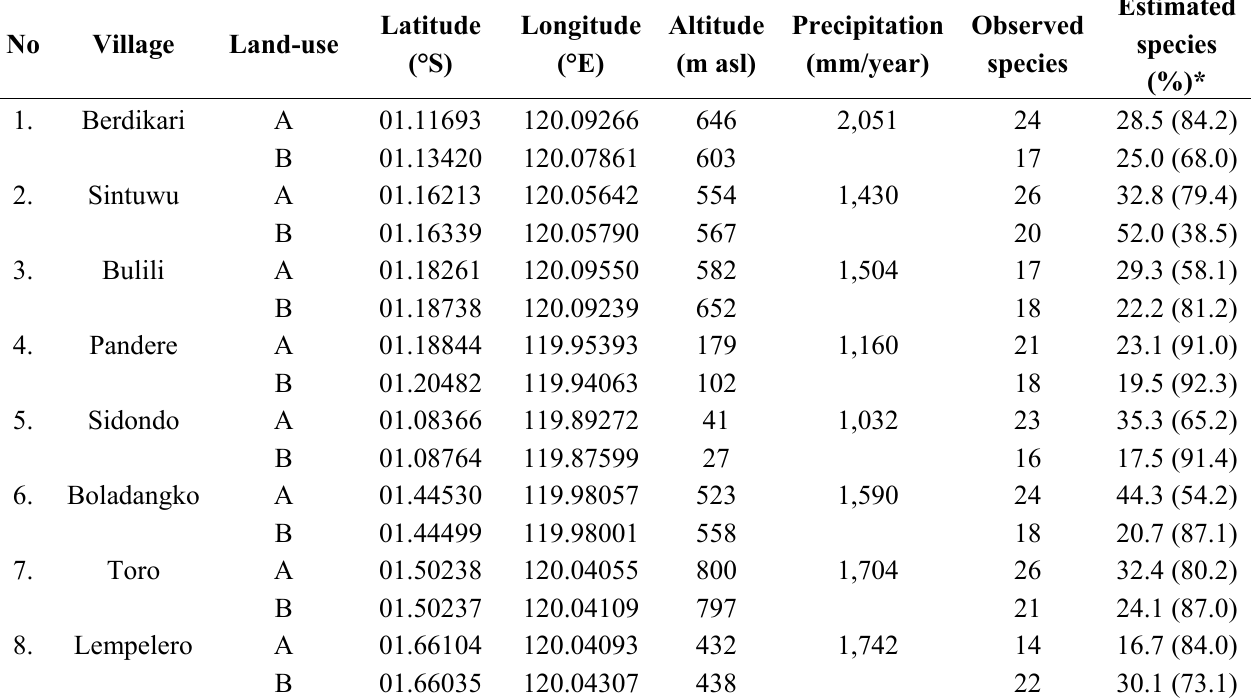
Table 1. Observed and estimated ant species richness of the 16 plots with different land- use (A: shaded; B: unshaded cacao agroforestry) and different precipitation located in eight villages around Lore Lindu National Park, Central Sulawesi,